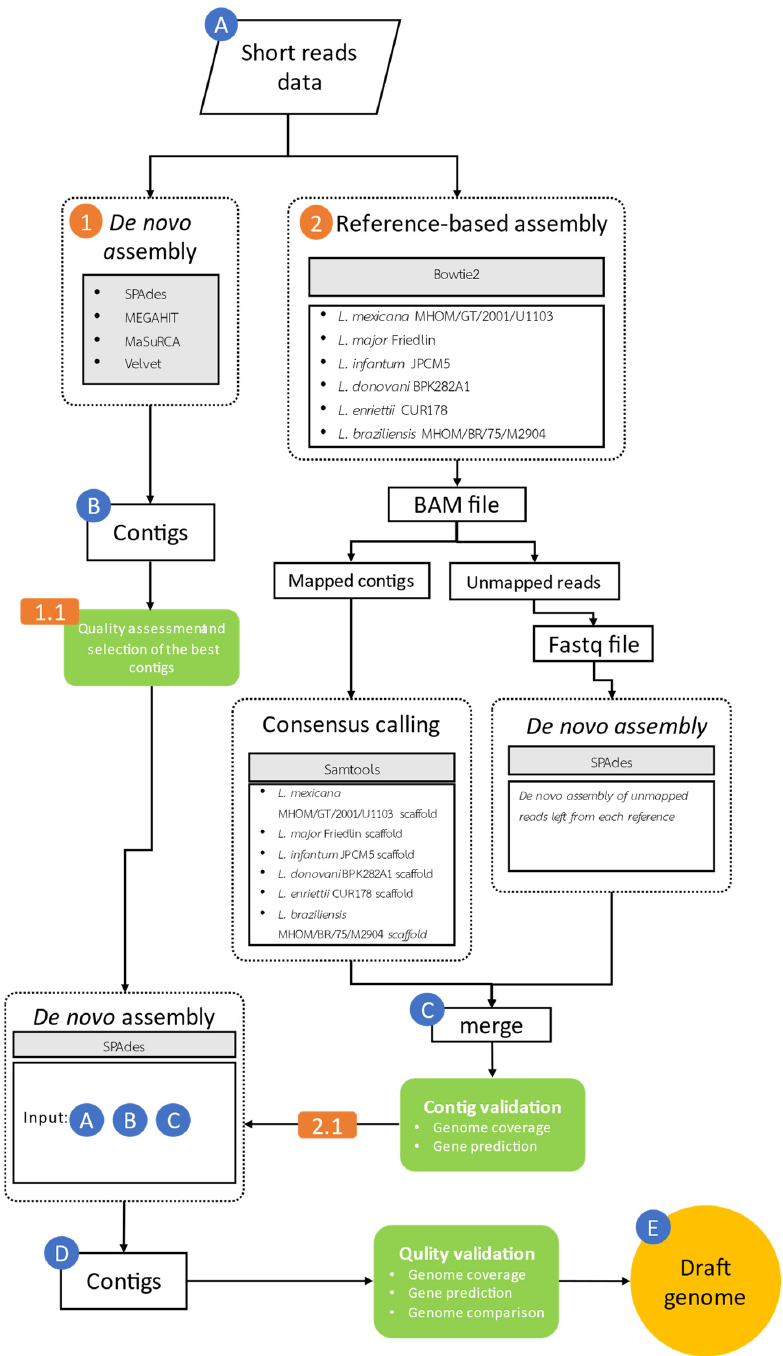
Figure 1. Diagram overview showing the Illumina read data management workflow, comparing the de novo method and the reference-based assembly.